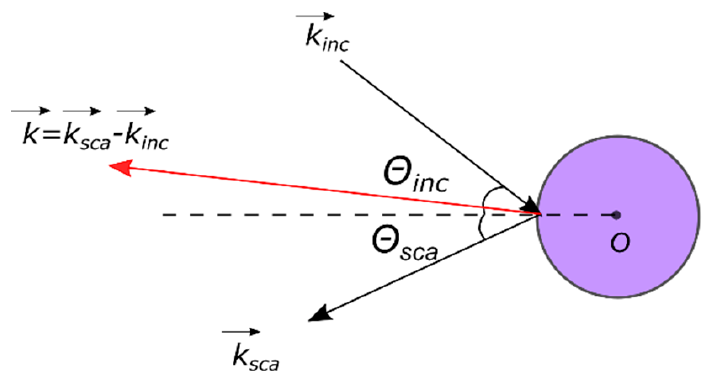
Figure 1. Incidence and scattering vectors when the laser beam was shot at the particle.